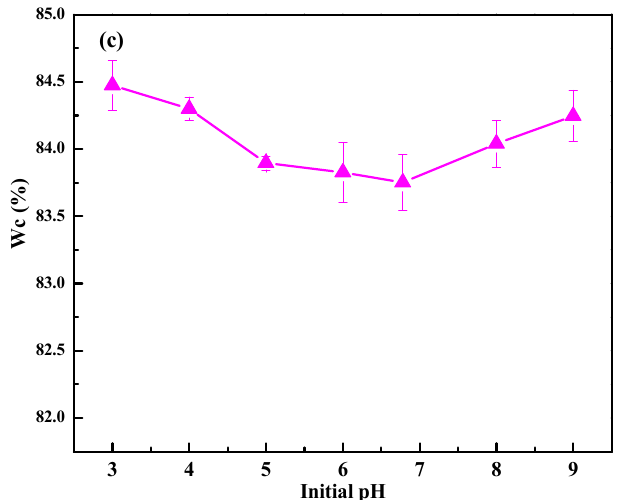
Figure 1. Effect of initial pH on performance indices (( a ) CST, ( b ) SRF, and ( c ) W C ) of sludge de- watering. Conditions: KIO 4 dose = 1.4 mmol/g VSS; Fe( Ⅱ )/KIO 4 molar ratio = 1.2.